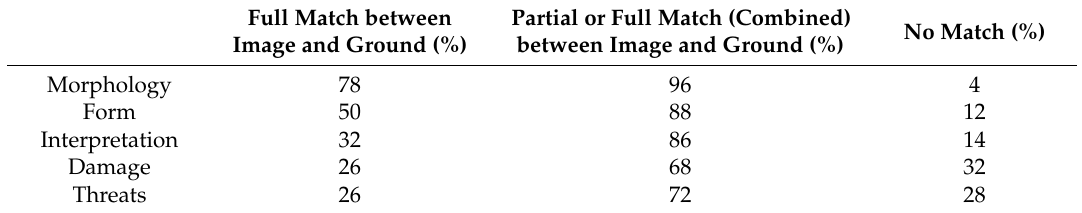
Table 11. Concordance of interpretations table N = 50 sites surveyed with EAMENA methodology. Full Match between Image and Ground (%)